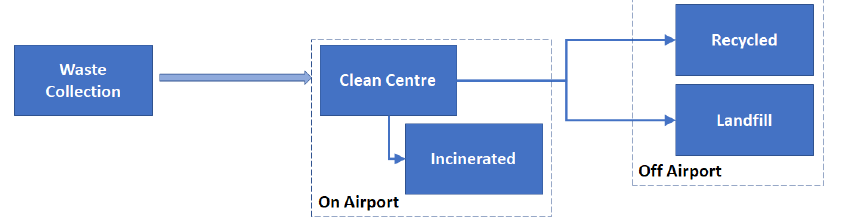
Figure 2. The waste disposal chain at Kansai International